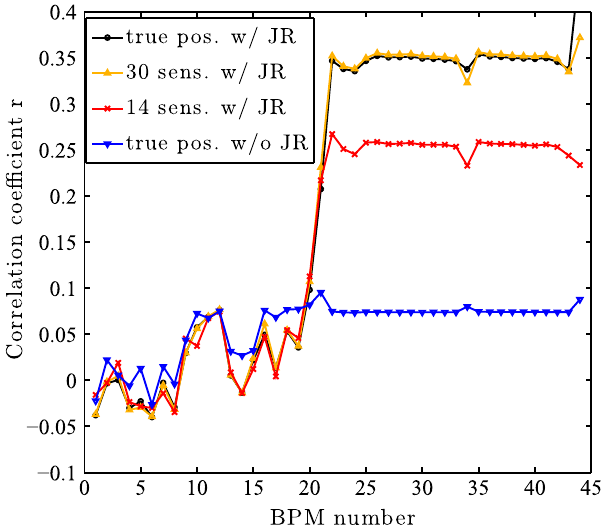
FIG. 7. Correlation coefficient r at the BPM locations along the beam line in horizontal direction. The prediction results for known quadrupole positions (true pos.) are shown with and without removal of the incoming orbit jitter (JR).